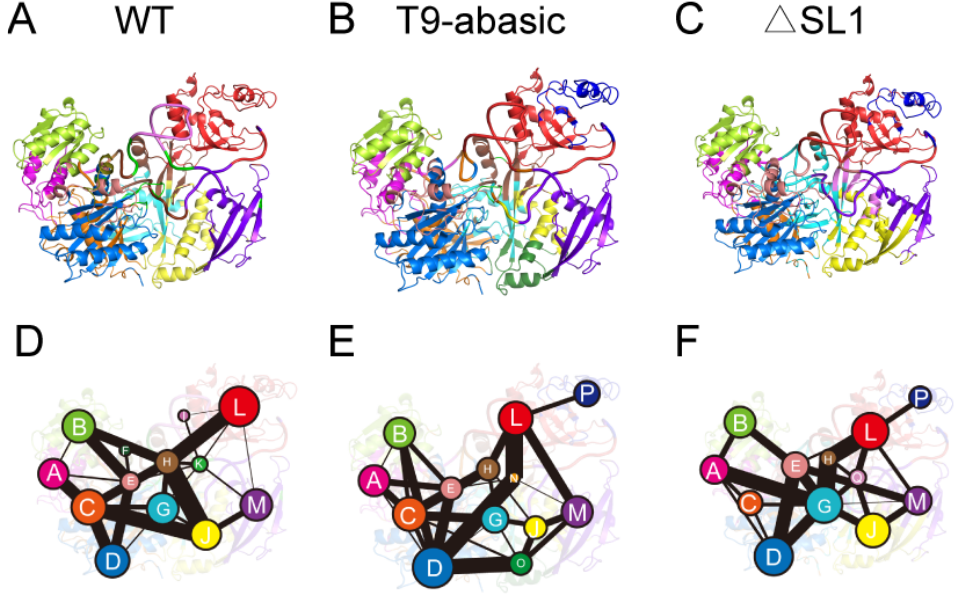
Figure 6. Community network of the Ago–RNA complex. Community composition in the WT system ( A ), the T9-abasic system ( B ) and the ∆ SL1 system ( C ). The community network in the WT system ( D ), the T9-abasic system ( E ), and the ∆ SL1 system ( F ). Areas of the circles represent the numbers of residues in corresponding communities, and the widths of sticks connecting communities represent the intercommunity connections, respectively.